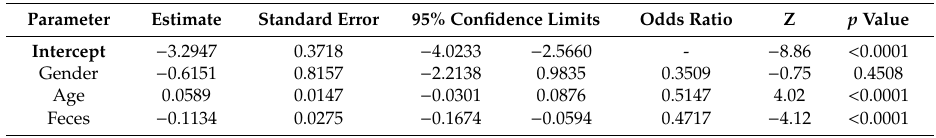
Table 2. Associations between excretion of mucous stools and age, gender, and feces output in captive giant pandas ( n = 18) during a 15-year prospective study in China.